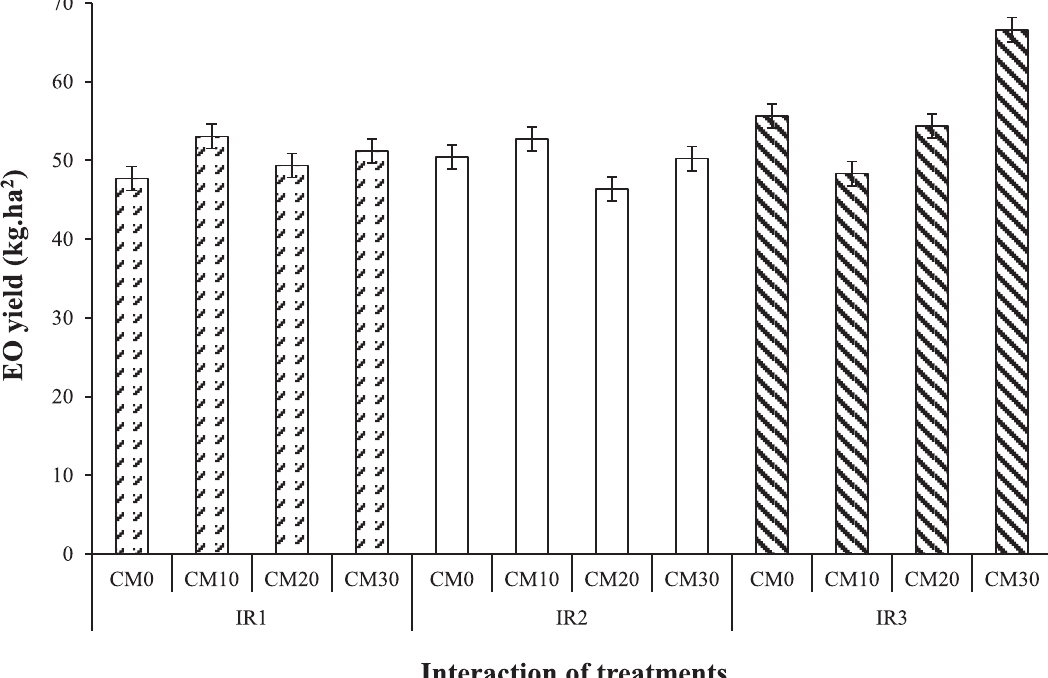
Figure 3 - Effect of irrigation intervals (IR) and cattle manure levels on (CM) essential oil yield (kg ha -1 ). Vertical bars indicate standard